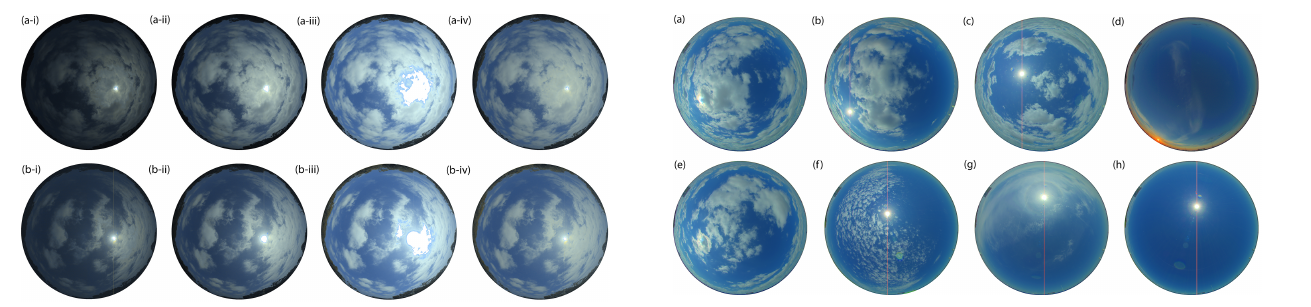
Figure 8. USI 1.2 high dynamic range (HDR) exposure sequence for (a) 23 May 2013, 03:22pm PDT and (b) 23 May 2013, 02:48pm for integration times of (i) 30, (ii) 120, and (iii) 480ms. (a-iv) and (b-iv) show the final HDR composites.